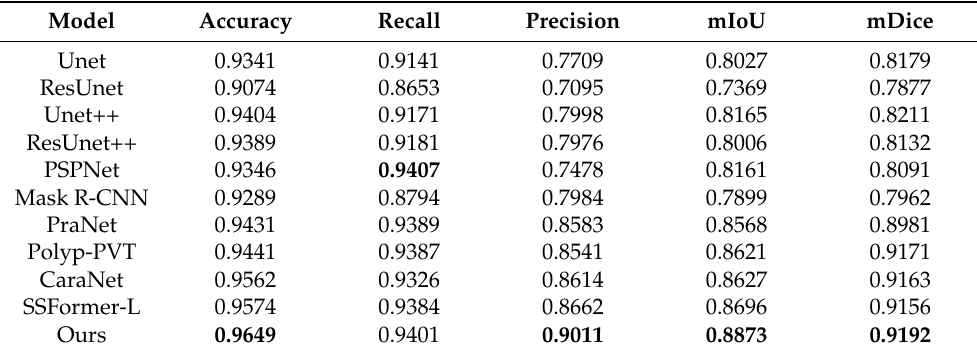
Table 2. Index results of different algorithms on the test